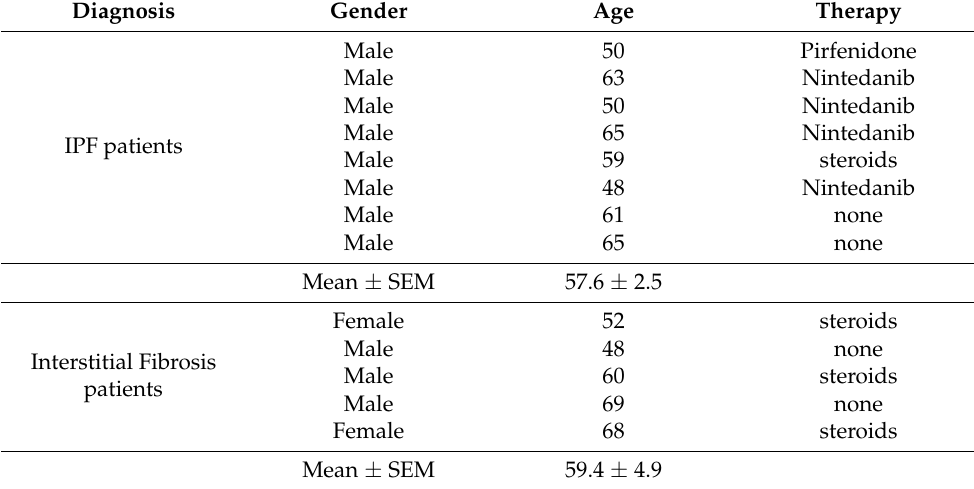
Table 1. Details of IPF and interstitial fibrosis patients. SEM: standard error of mean. Diagnosis